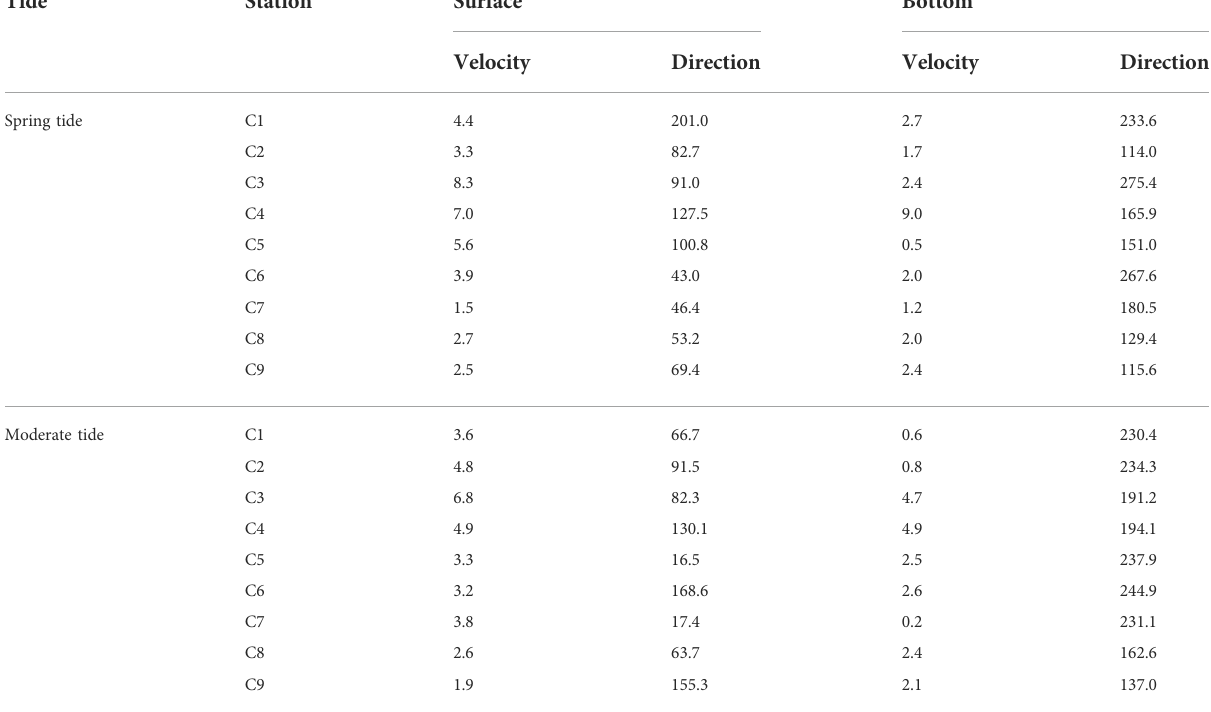
TABLE 1 Residual current at each station in the spring and moderate tides (velocity: cm/s, direction: degrees). Tide